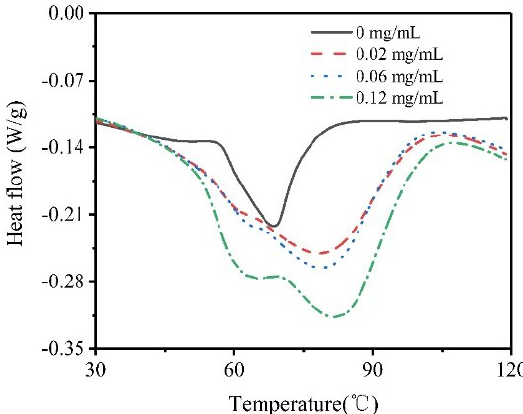
Figure 7. Differential Scanning Calorimetry (DSC) analysis of type I collagen with different concentrations of collagenase I (0, 0.02, 0.06, 0.12 mg/mL).